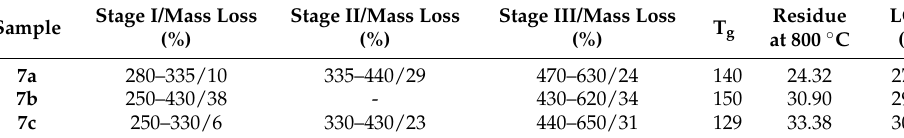
Table 4. Thermal degradation parameters for 7a – c .